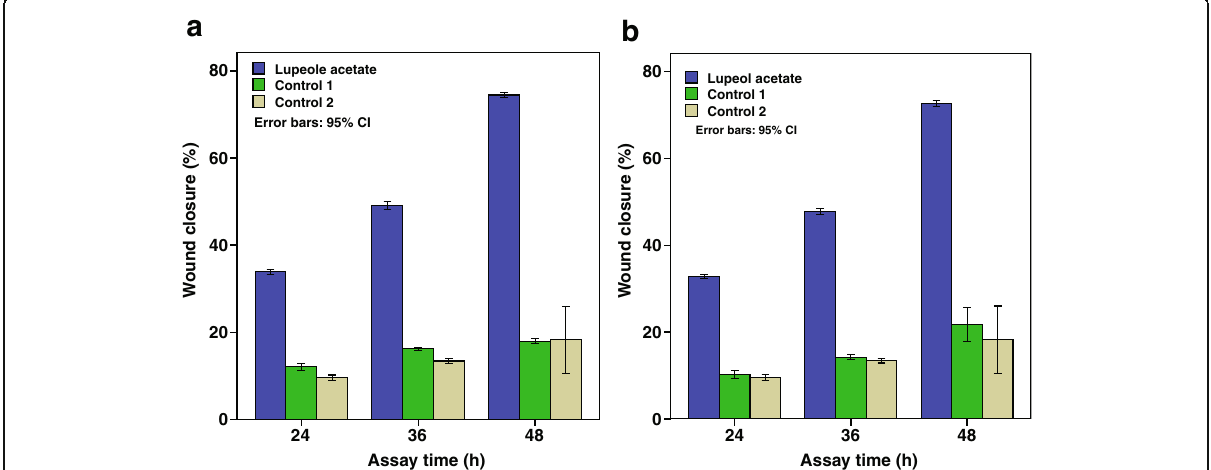
Fig. 7 Percentage wound closure in the presence of lupeol acetate ( 3 ) with time. a BHK cell line. b MDCK cell line. (Bars represent the mean confidence intervals of 95% of nine measurements in the three experiments)